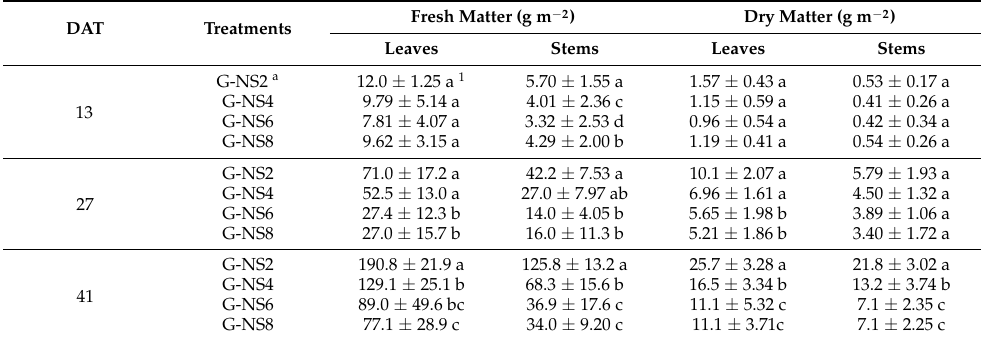
Table 2. Mean fresh and dry matter (g) ( ± SE) of leaves and stems of basil plants irrigated by means of the G-NS during the first experimental period.